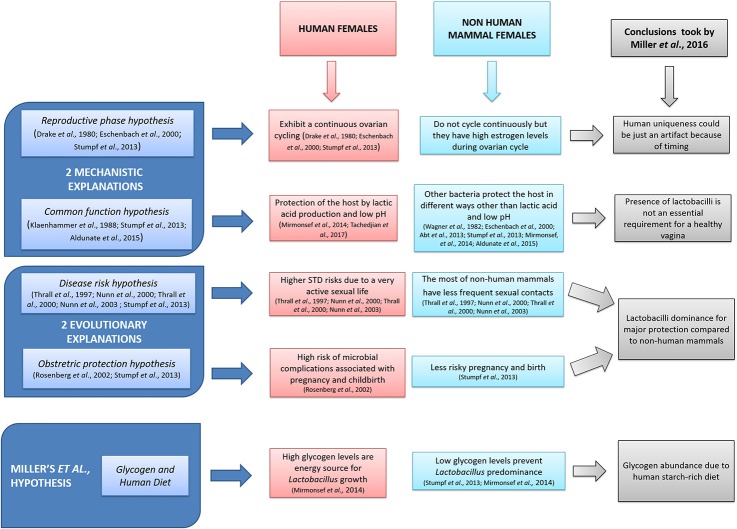
Miller et al. (2016): a schematic representation.